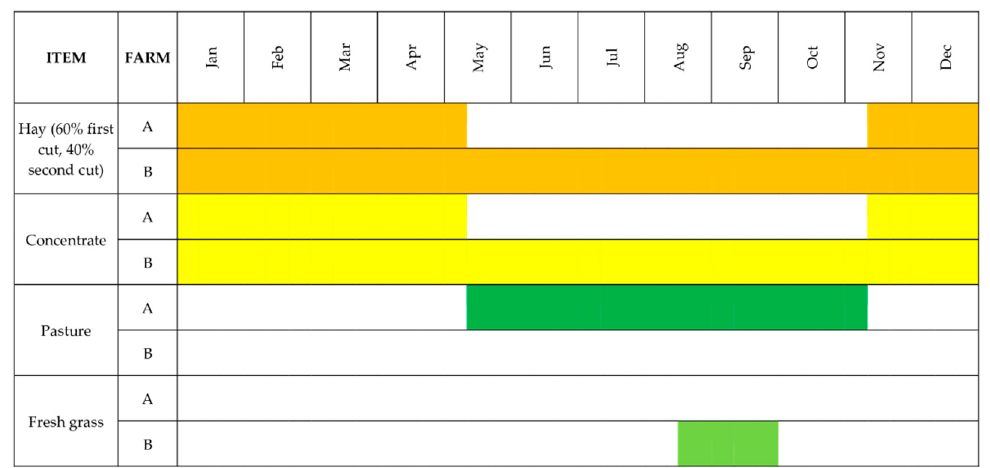
Figure 1. Rations composition of the two di ff erent farming system (“A” farm practiced grazing, “B” farm not) during the experimental period.